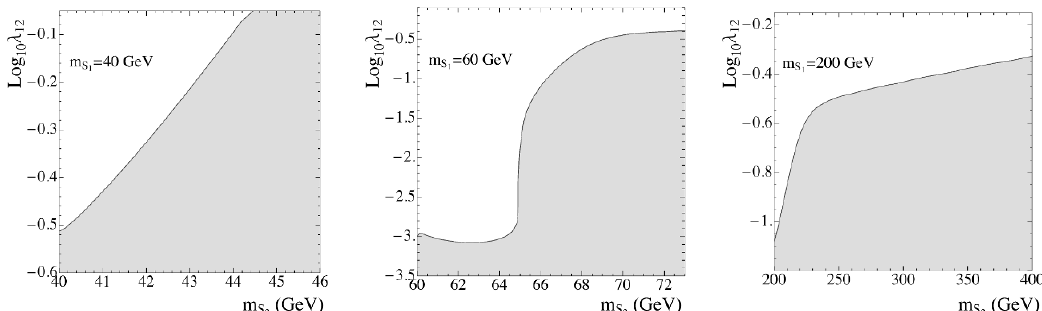
Figure 5 . Range of values in the illustrative values of the DM mass: (from left to right) m S DM-Higgs coupling has been fixed to λ 1 = λ 2 12 / (4 π ) 2 . The solid black line represents the Planck result. The grey area below this line is excluded since Ω S